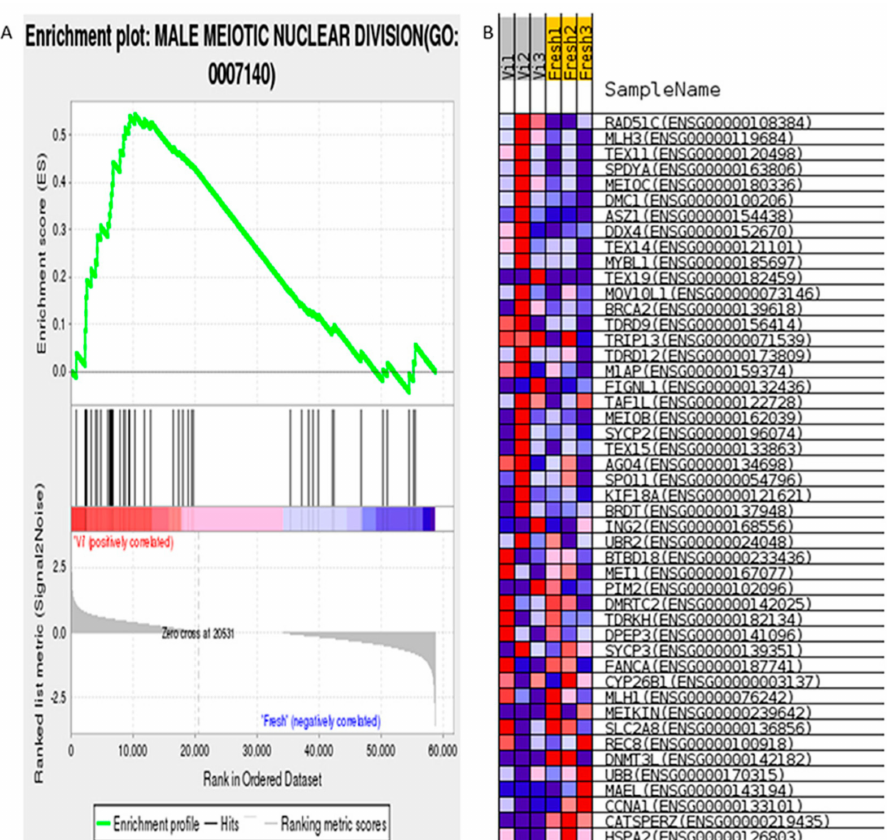
Figure 3. GSEA result of vitrified human spermatozoa: male meiotic nuclear division (GO ID:0007140). ( A ) Enrichment plot of male meiotic nuclear division. ( B ) Visualization of enriched genes in male meiotic nuclear division process in cryoprotectant free vitrified spermatozoa and fresh spermatozoa groups. Positive result indicates correlation with control group phenotype, non-significant value indicates relationship with experimental group (( A ) and Figure 1A,C and Figure 2A; more examples can be seen in Figshare in file GSEA/1.GO/SfvsFresh/Sf/pos_snapshot.html)